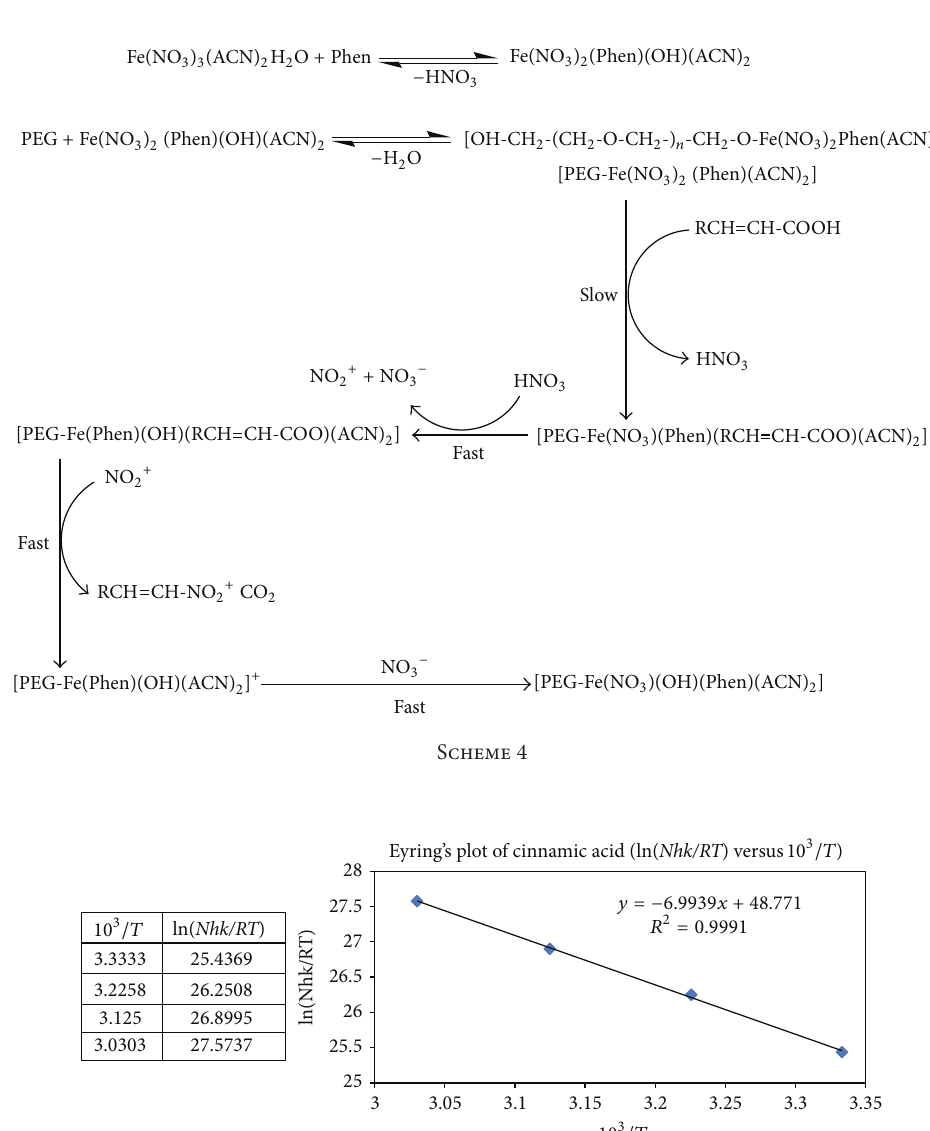
Figure 6: Eyring’s plot of cinnamic acid (ln (𝑁ℎ𝑘/𝑅𝑇) versus 10 3 / 𝑇 ). Kinetic study with [PEG-300] = 6.24 × 10 −1 moldm −3 .